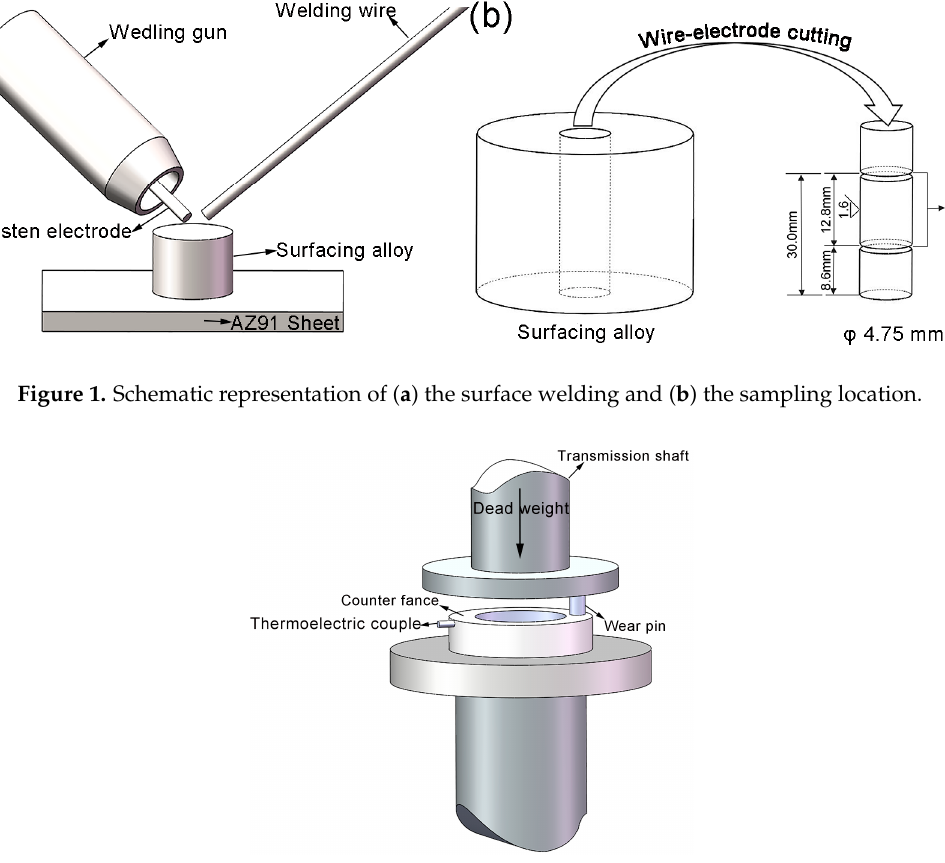
Figure 2. Schematic representation of surface welding the pin-on-disc experimental configuration.